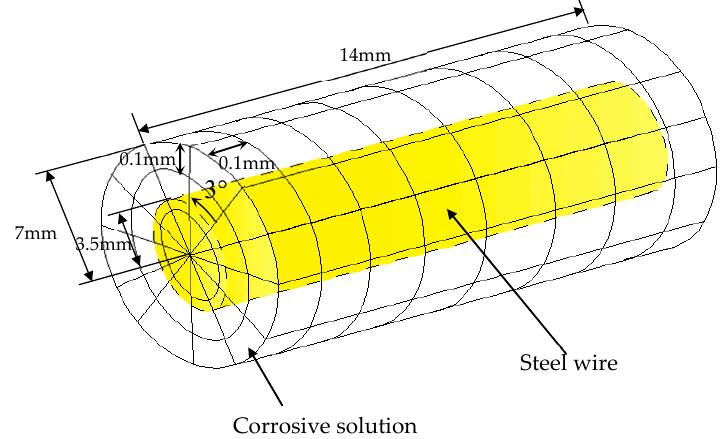
Figure 2. Schematic diagram of cellular automata (CA) model for the corrosion process of high-strength steel wire.